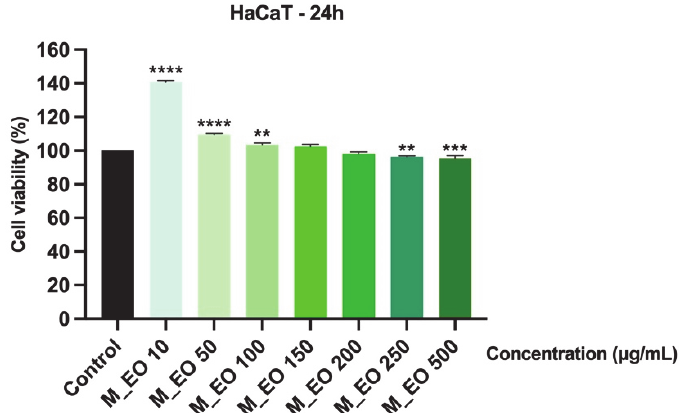
Figure 4 . Viability assessment of Mentha piperita L. essential oil—M_EO (10, 50, 100, 150, 200, 250 and 500 μ g/mL) in HaCaT cells at 24 h post ‐ stimulation by MTT assay. The results are presented as cell viability percentage (%) normalized to control (non ‐ stimulated) cells. These data represent the mean values ± SD of three independent experiments performed in triplicate. One ‐ way ANOVA test was performed to determine the statistical differences in rapport with control group followed by Dunnett’s multiple comparisons post ‐ test (** p < 0.01, *** p < 0.001 and **** p < 0.0001).